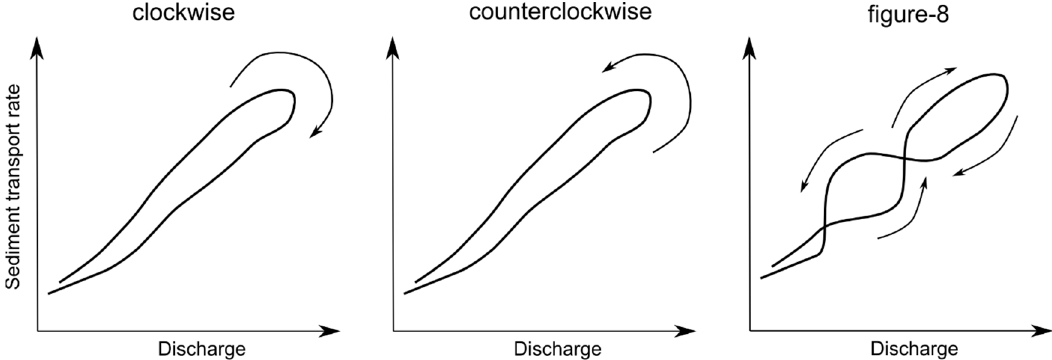
Figure 3. Types of bedload transport hysteresis. Arrows denote hysteresis direction.